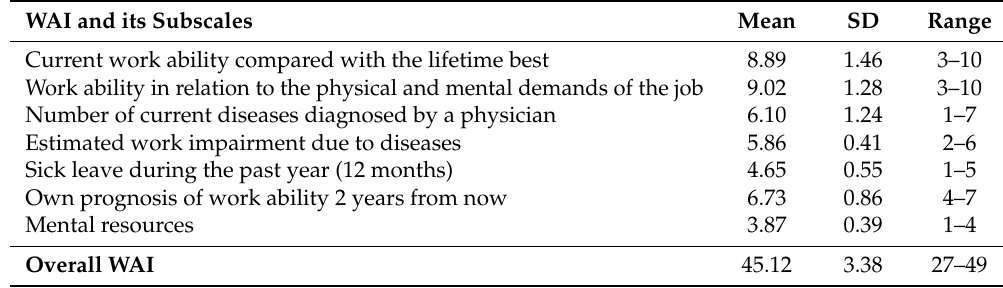
Table 2. Average scores for WAI and its subscales.